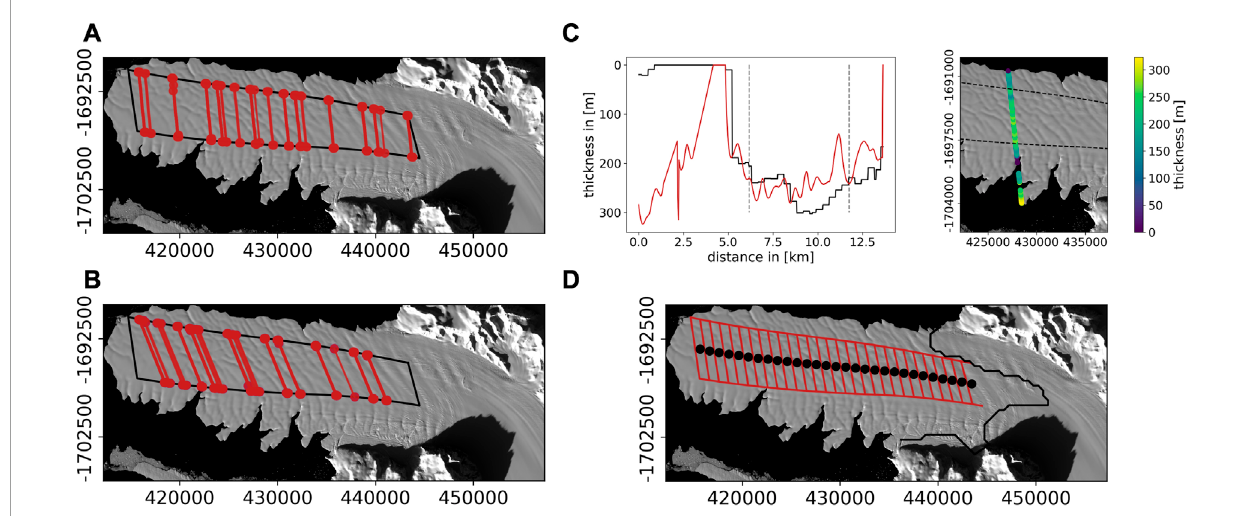
FIGURE 2 Aviator Ice Tongue flux gates from ICESat-2 (A) descending paths and (B) ascending paths in red with a black polygon showing the area between flowlines calculated using velocity trajectories. The polygon area is used to calculate the basal melt. Panel (C) shows on the left the comparison between the ICESat-2 derived thickness in red and BedMachine in black over one ICESat-2 track (1,098 cycle 13 from 03 December 2021) across the ice tongue. The flowlines are shown as dashed grey lines. On the right the same track is overlaid over a Sentinel-2 greyscale image, the colour map indicates the thickness and the dashed lines are the derived flowlines. On panel, (D) in red the final gates and areas that are used for the basal melt calculations using the modelled ice flux. Black dots mark the centre of each polygon associated with distance in the x -axis of Figures 5A–C and Figures 6A–C . Sentinel-2 greyscale image from 07 March 2020 in the back of all panels.